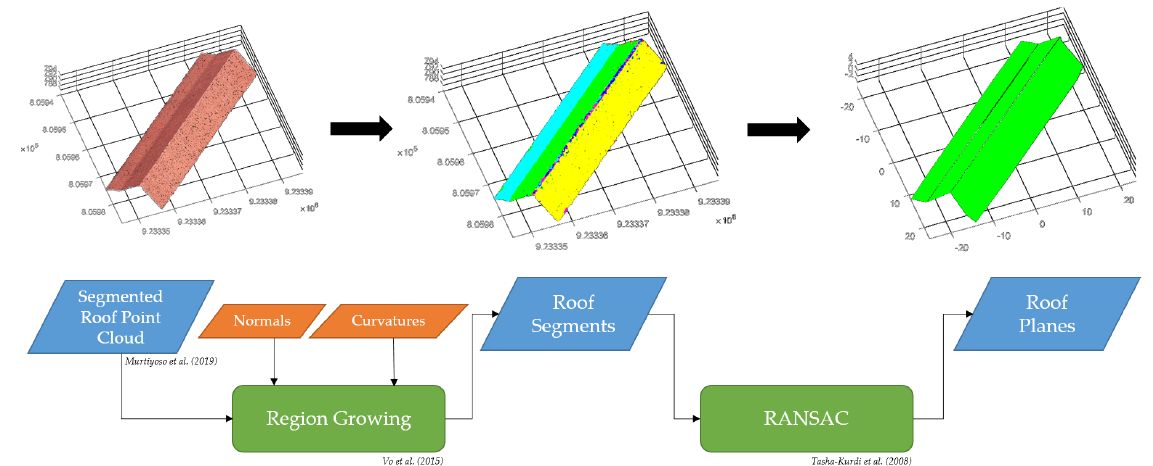
Figure 1. General illustration of the developed approach to extract roof 3D primitives from the input Unmanned Aerial Vehicle (UAV) images-derived point